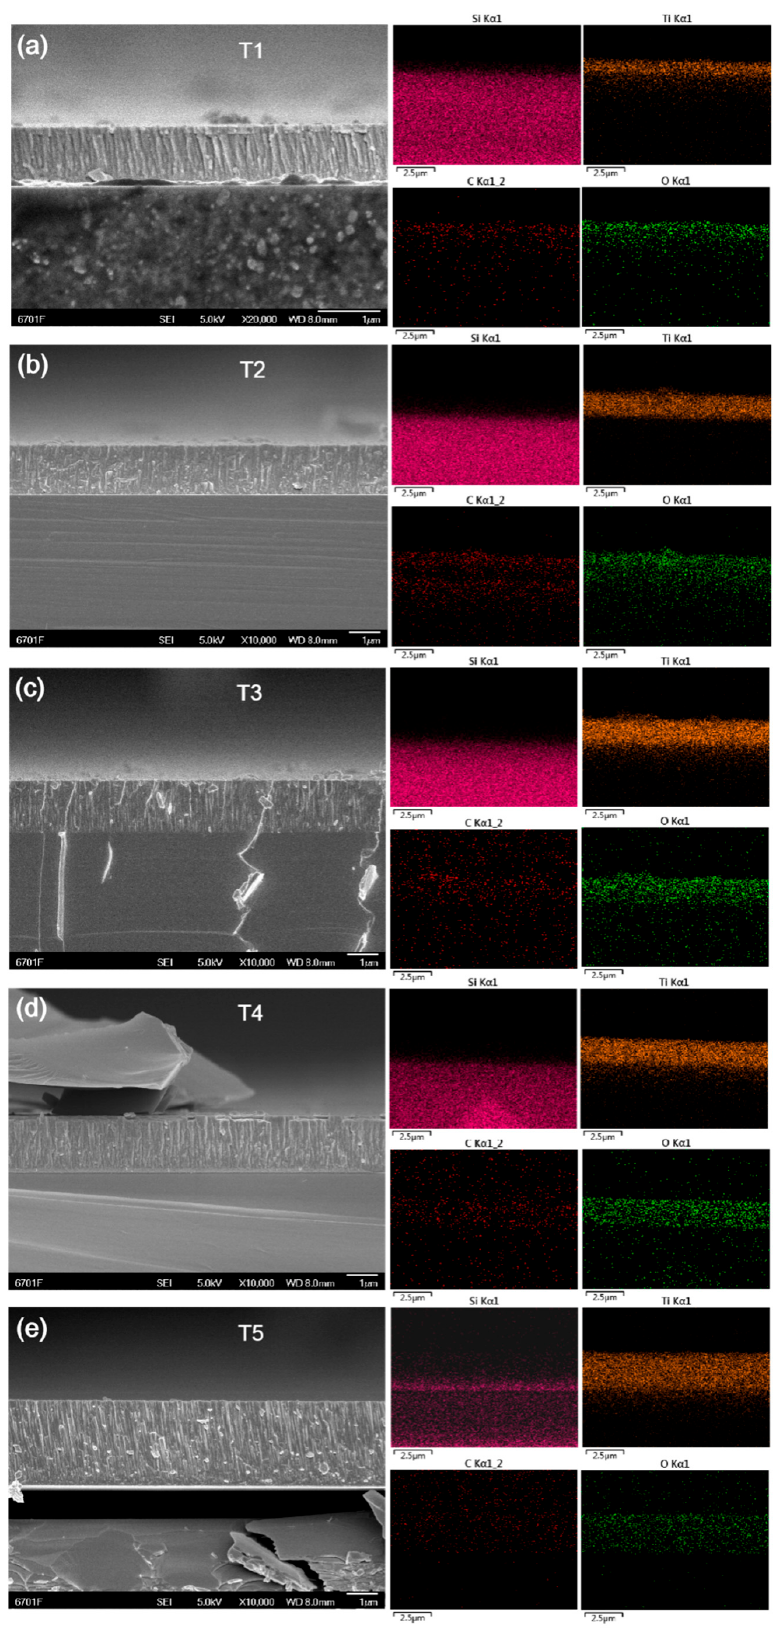
Figure 4. Cross-section scanning electron microscopy (SEM) images and EDS-map of T1 to T5 ( a – e